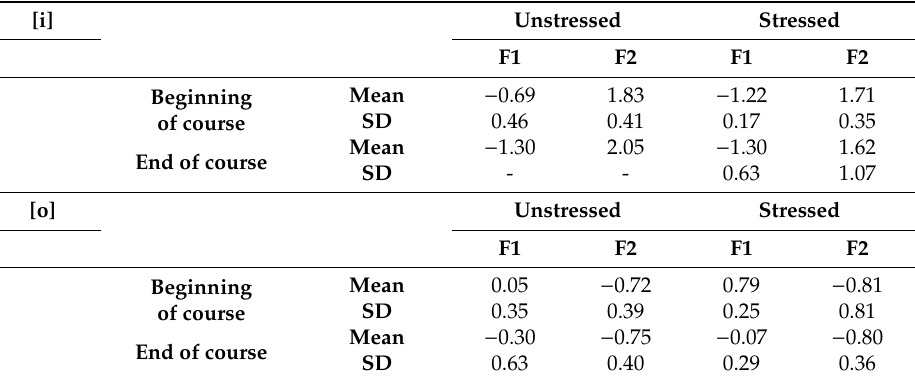
Table 7. Mean Lobanov-normalized F1 and F2 values for Informant E.